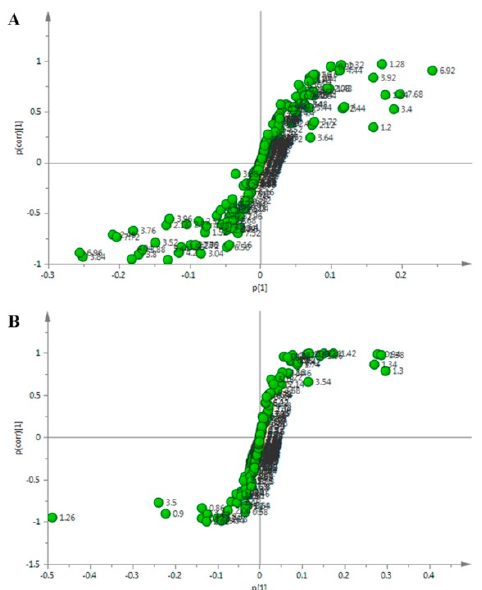
Figure 7. S-plot analysis showing the potential biomarkers in the adventitious root after the MeJA treatment. ( A ) Methanol aqueous phase. ( B ) Chloroform phase.